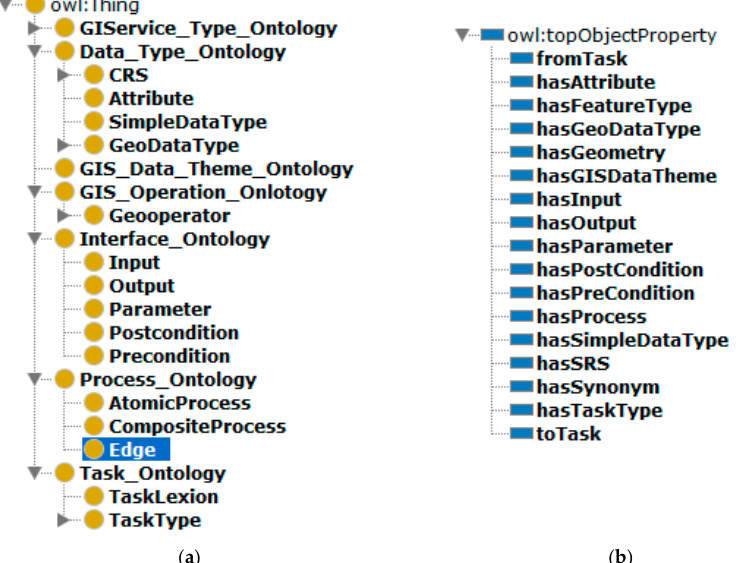
Figure 8. An excerpt of ontologies where ( a ) depicts the classes of ontologies, and ( b ) illustrates the object properties between classes. object properties between